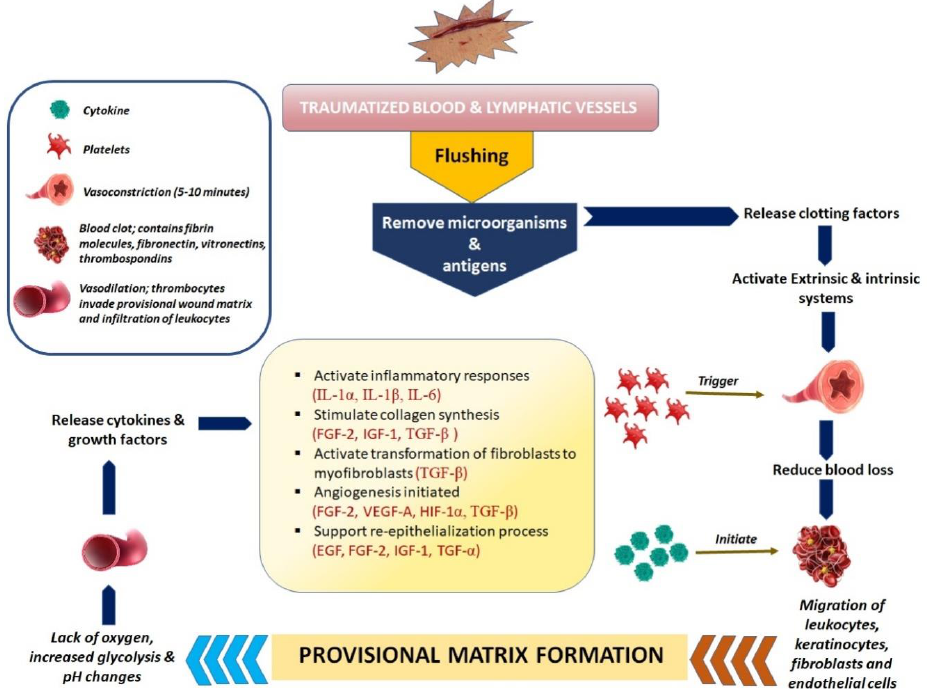
Figure 2. Vascular mechanism for Haemostasis and coagulation. This mechanism is regulated by a dynamic equilibrium between endothelial cells, thrombocytes, coagulation, and fibrinolysis, which also influences the amount of fibrin deposited at the wound site and affects how quickly the reparative processes proceed. 2.2. Inflammation: Cellular Mechanism